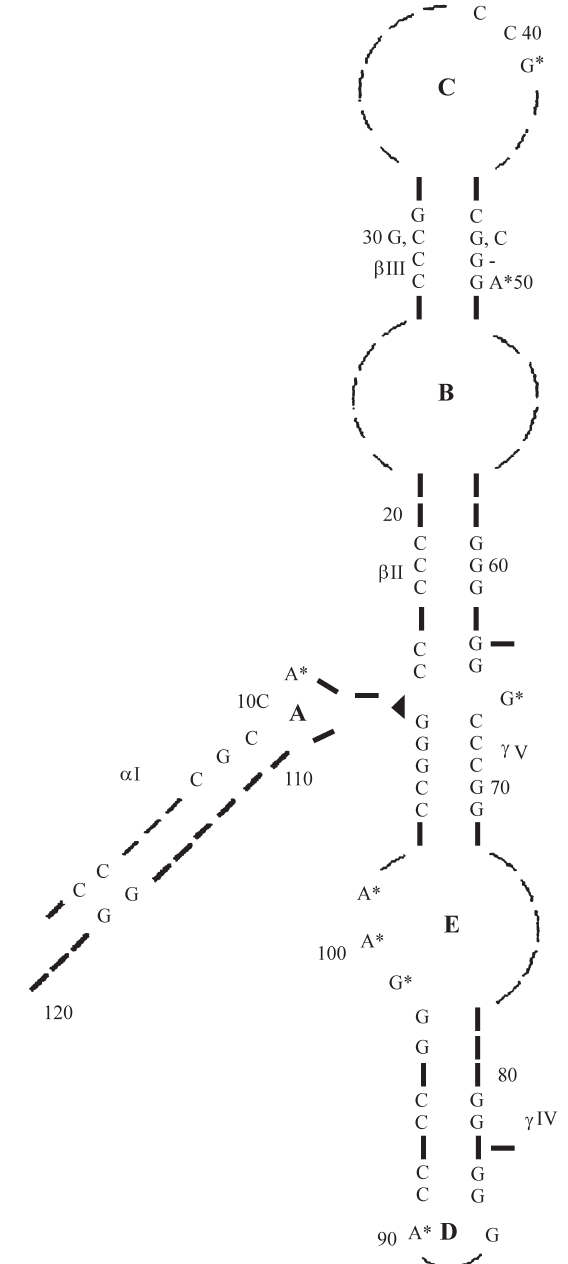
Figure 4 - Location of G and C clusters along the secondary structure of 5S rRNA in deuterostomes. *, invariant positions. Bases 49 and 50, 63, and 83 are bulged. The complex loop A is formed by bases 10-13, 66 and 109. Drawing according to the model of Szymánski et al.